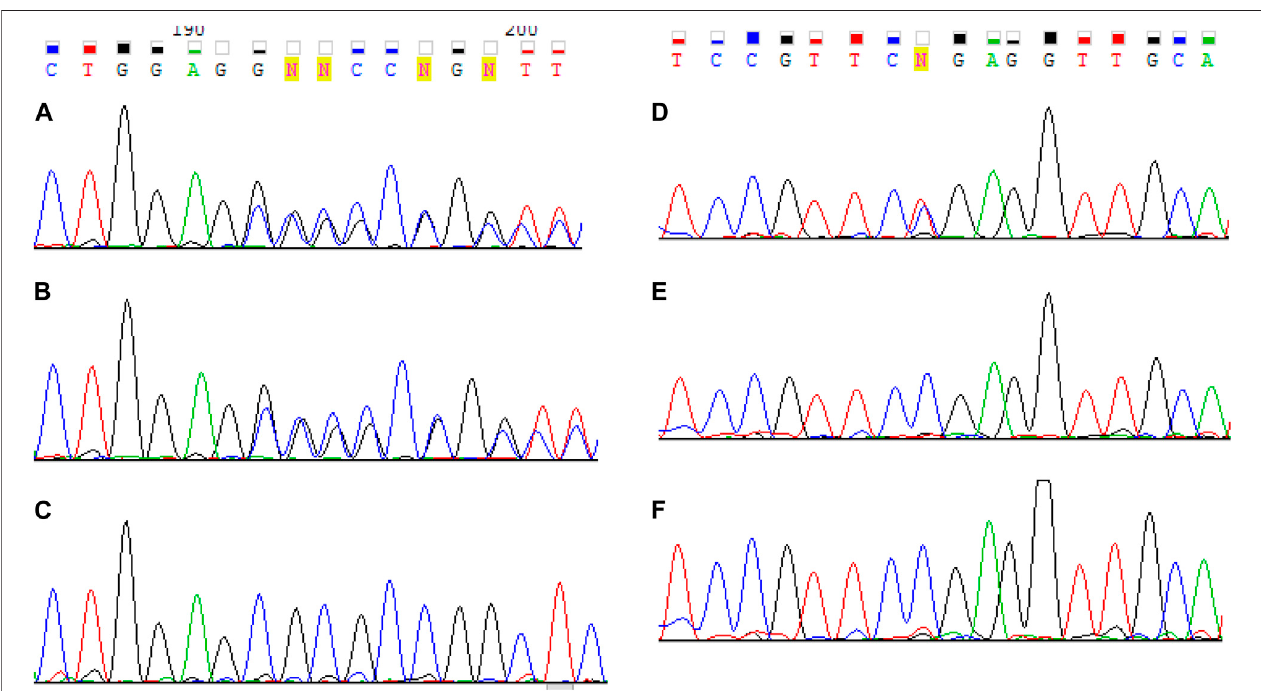
FIGURE 2 | Sanger sequencing results of LAMA2 exon 12 for the proband (A) , his mother (B) and father (C) and exon 65 for the proband (D) , his mother (E) and father (F) . The proband were found to have two pathogenic variants s . 1755del and c. 9253C > T. One pathogenic variant s 1755del was identi fi ed in the mother. The father is presumed to have the pathogenic c.9253C > T variant in mosaic